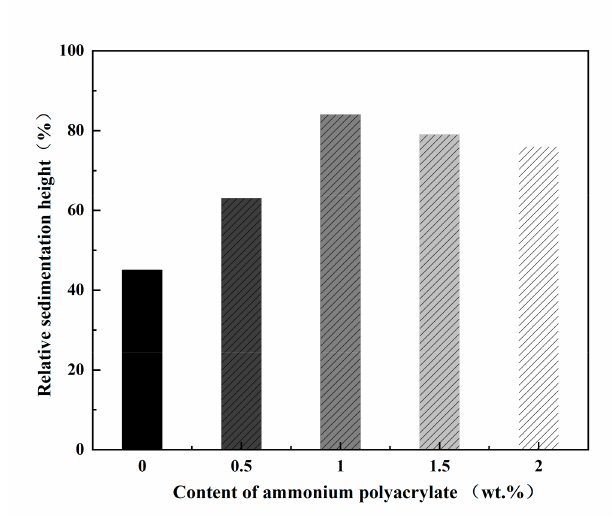
Figure 4. Relative sedimentation height of ceramic slurry.